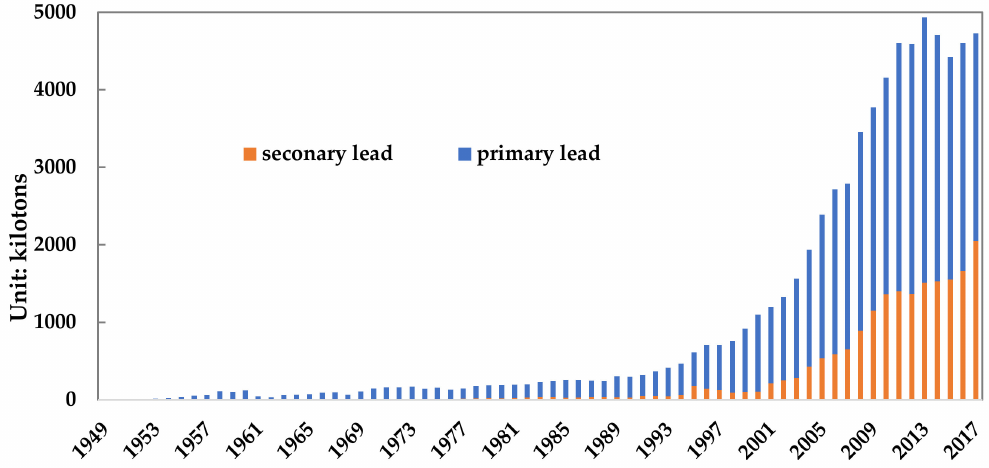
Figure 2. Changes in lead concentrate production from 1949 to 2017. (Data source: